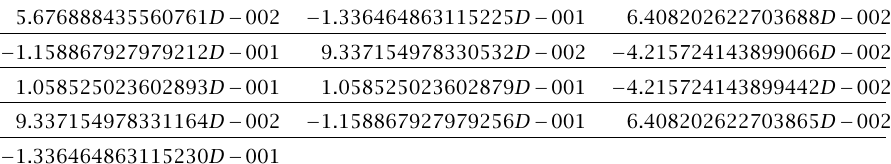
Table 3.5 . The charge distribution with n = 13 , l = 0 . 5 on γ 1 .